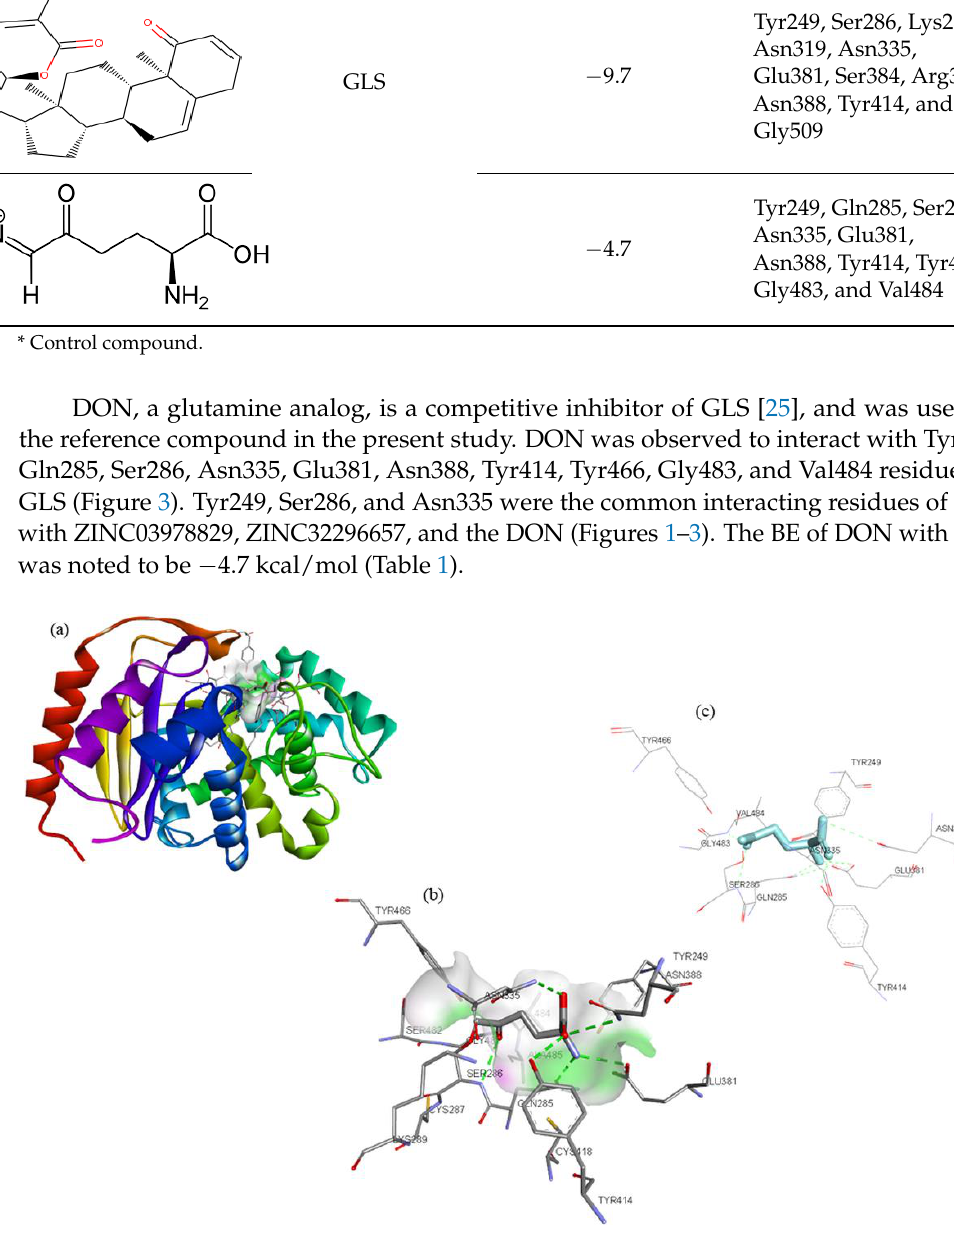
Figure 3. Visualization of DON (stick representation) in the binding pocket of GLS ( a ), interacting residues of GLS with DON ( b , c ). residues of GLS with DON ( b , c